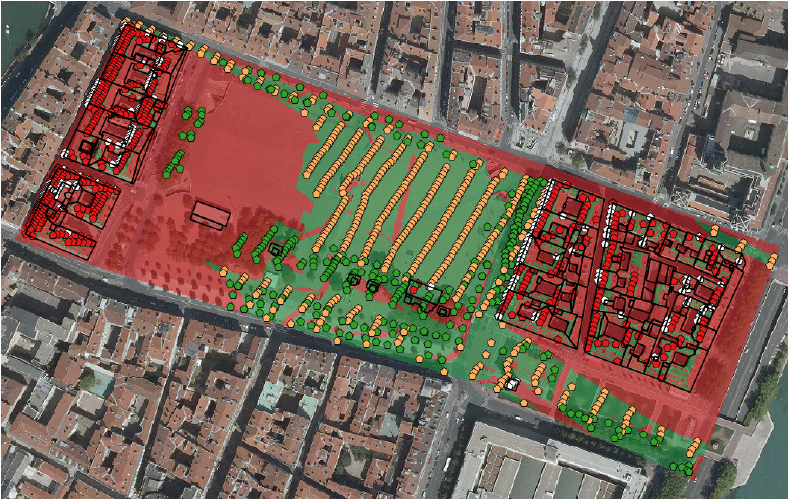
Figure 17. Same as Figure 16, with the addition of the visibility analysis from our tool (in green, vegetation; in yellow, terrain; in red, roofs; in white, building’s